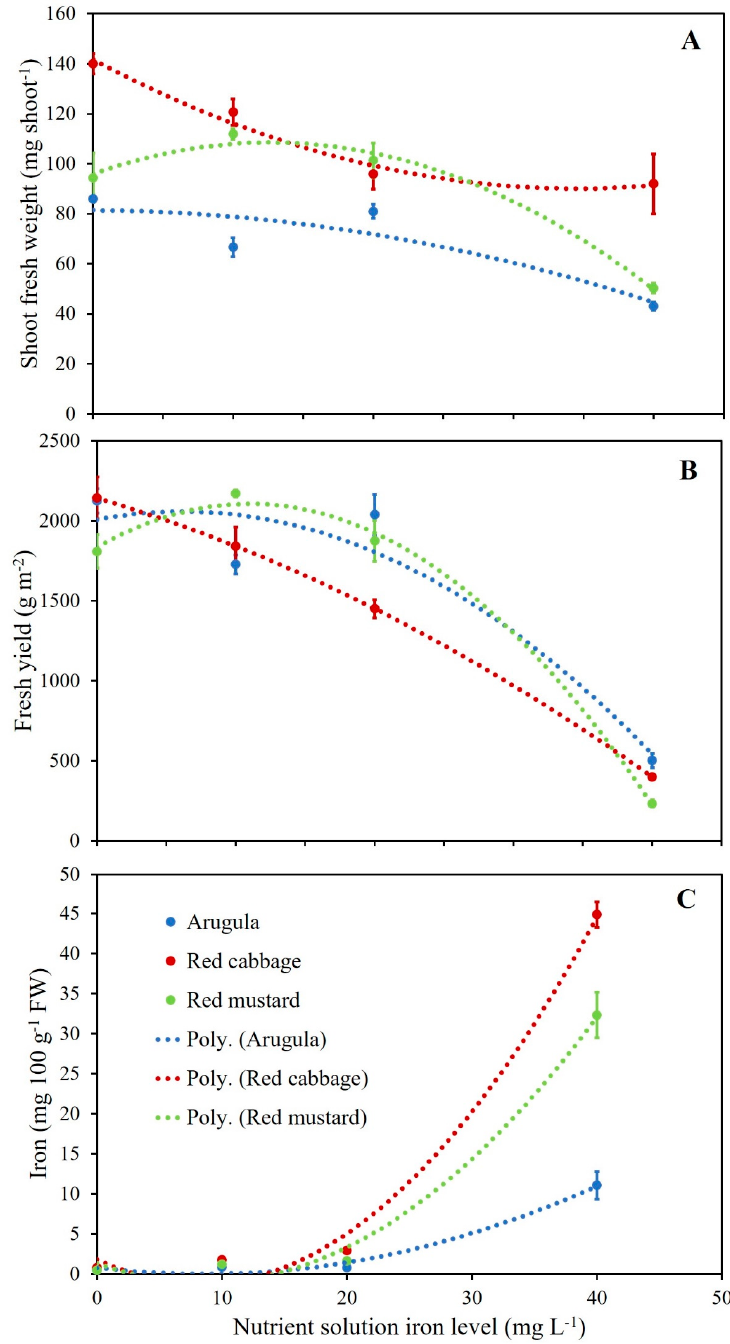
Figure 3. Relationship between single shoot fresh weight ( A ), fresh yield ( B ), iron plant tissue concentration ( C ) and nutrient solution iron concentration for arugula, red cabbage, and red mustard. Equations and coe ffi cient of determination ( R 2 ) are reported in Table